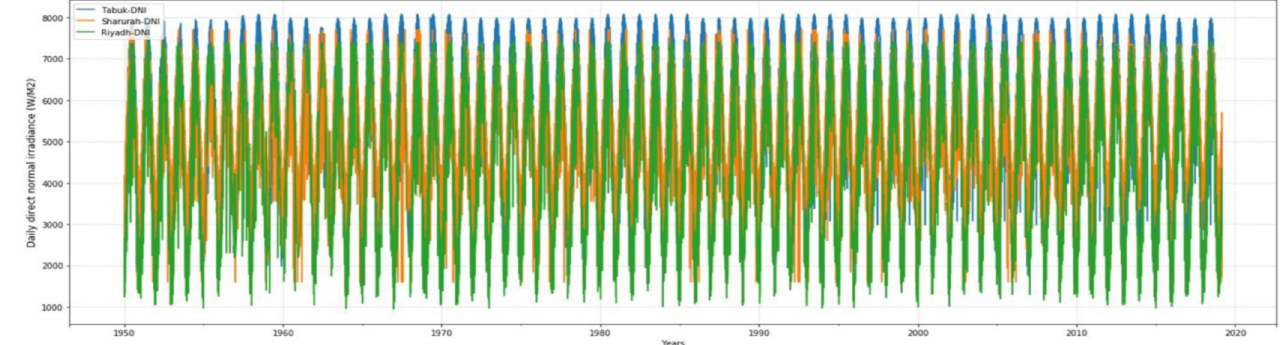
Fig. 6. The direct normal irradiance (DNI) performance of the three regions from 1950 to 2020 [9]. The lowest line is 100 Wm (cid:1) 2 and the highest line is 800 Wm (cid:1) 2 . The highest DNI is in Tabuk and the lowest is in Riyadh.